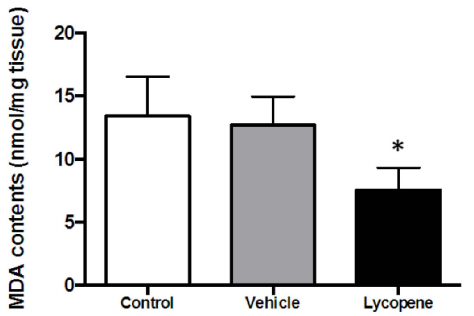
Figure 4. Malondialdehyde (MDA) levels of in vivo I/R cardiac tissue. Lycopene or vehicle was given to mice through tail vein injection after 20 min of in vivo regional ischemia, then followed by 20 min of reperfusion (I/R); control was not treated with vehicle or lycopene. LVs were harvested immediately after reperfusion then subjected to MDA assay. Values are means ˘ SEM, n ě 3 in each group, * p < 0.05 vs. control and